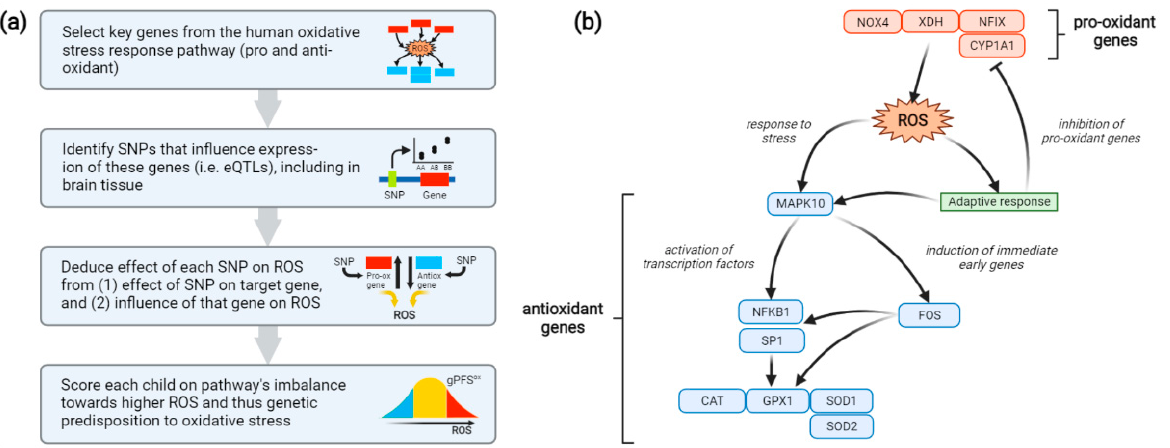
Figure 1. ( a ) Method used to construct a genetic pathway function score for oxidative stress (gPFS ox ). ( b ) Oxidative ‐ stress pathway encoded using gPFS ox . Included are 4 genes involved in the production of ROS (red) and 8 genes involved in the response to ROS (blue). NOX4 , NAD(P)H oxidase 4; XDH , xanthine dehydrogenase; NFIX , nuclear factor I X; CYP1A1 , cytochrome P450 family 1 subfamily A member 1; MAPK10 , mitogen ‐ activated protein kinase 10; NFKB1 , nuclear factor kappa B subunit 1; SP1 , specificity protein 1; CAT , catalase; GPX1 , glutathione peroxidase 1; SOD1 , superoxide dismutase 1; SOD2 , superoxide dismutase 2; ROS, reactive oxygen species; SNP, single ‐ nucleotide polymorphism; eQTL, expression quantitative trait loci.